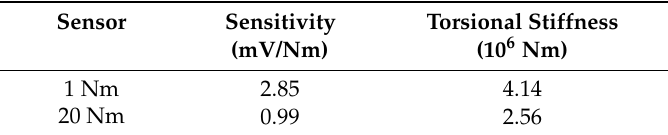
Table 7. Sensitivity and torsional rigidity for sensor type Hub-Sprocket.